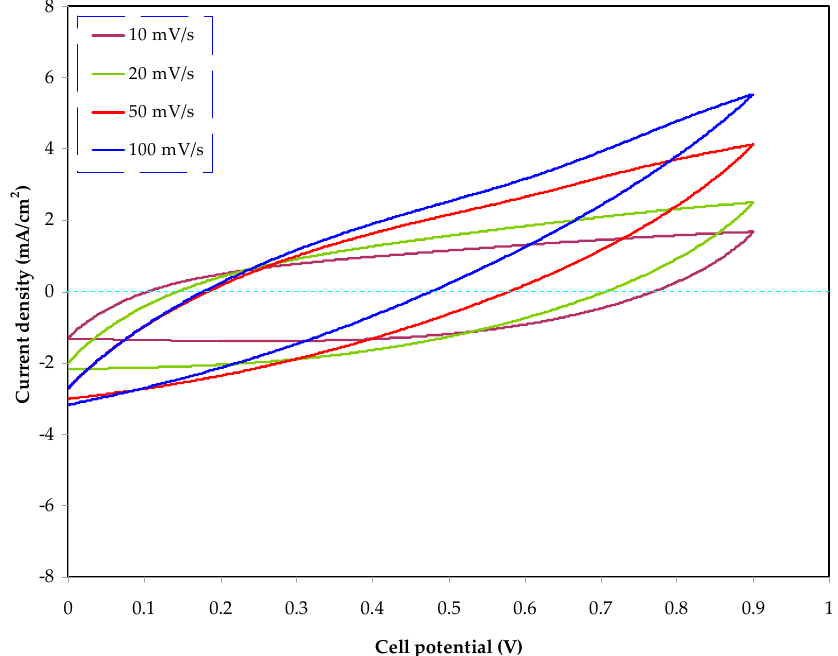
Figure 11. Cyclic voltammograms for the assemble EDLC in the potential range of 0 to 0.9 V.